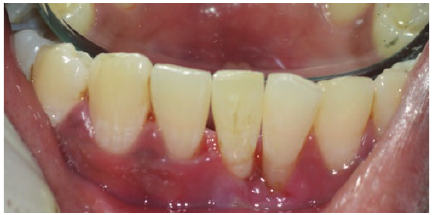
Figure 10: Recall visit, 1